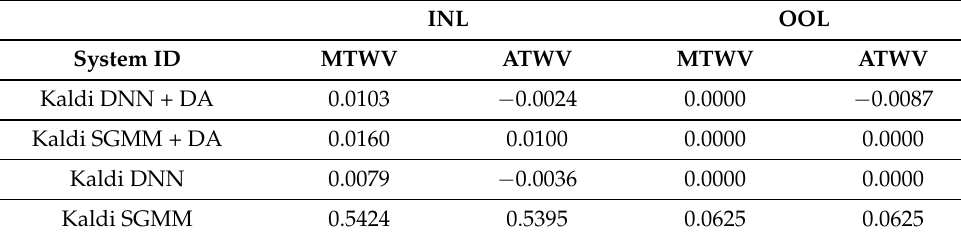
Table 20. System results of the STD task for SPARL20 test data for in-language (INL) and out-of- language (OOL) queries.